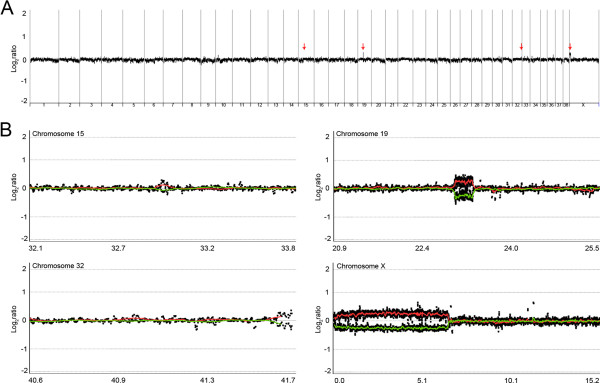
Dye-swap analysis for the clone-3 genome. (A) Genome-wide signal intensity plot from clone-3. Four CNV regions were identified in the clone-3 genome (red arrow). The X-axis represents individual chromosomes and the Y-axis represents signal intensity ratio (clone-3/donor) on a log2 scale. (B) Log2ratio plots around the four CNV regions in clone-3. All CNV-Gs identified in clone-3 (red line) show flipped signal intensity plots (green line) in the dye-swap hybridization. The X-axis represents genomic position (Mb), and the Y-axis represents signal intensity ratio on a log2 scale.